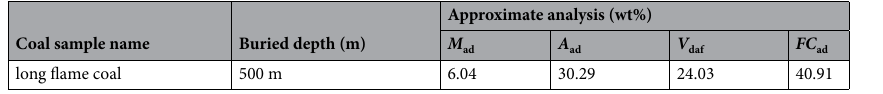
Table 1. Basic properties of coal samples. M ad moisture content after air-drying, A ad ash content after air- drying,